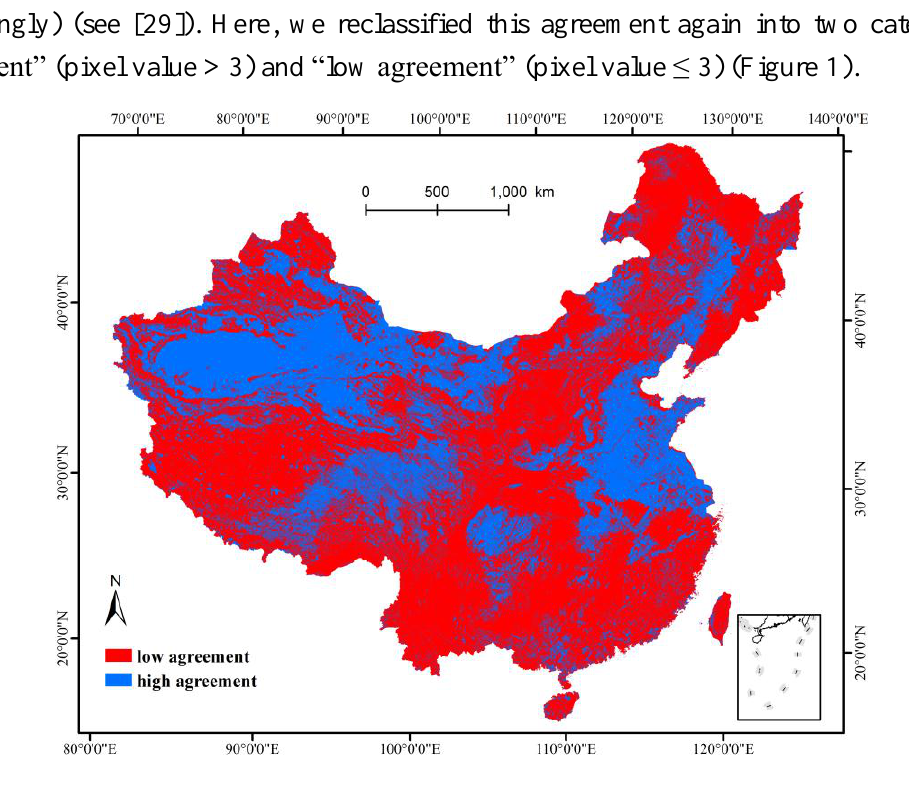
Figure 1. Reclassified agreement map in